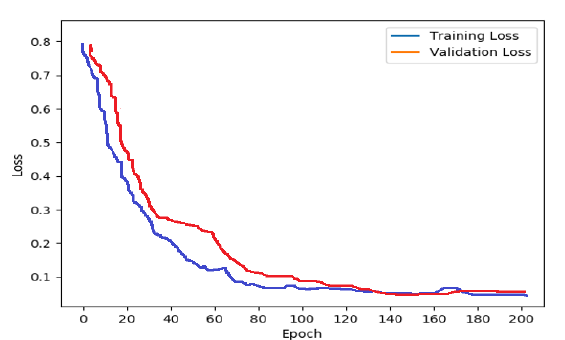
Figure 13. Training and Validation loss (ResNet).